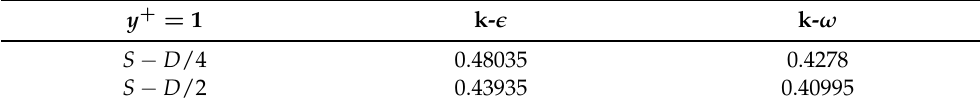
Table 2. Cold flow case with y + = 1.